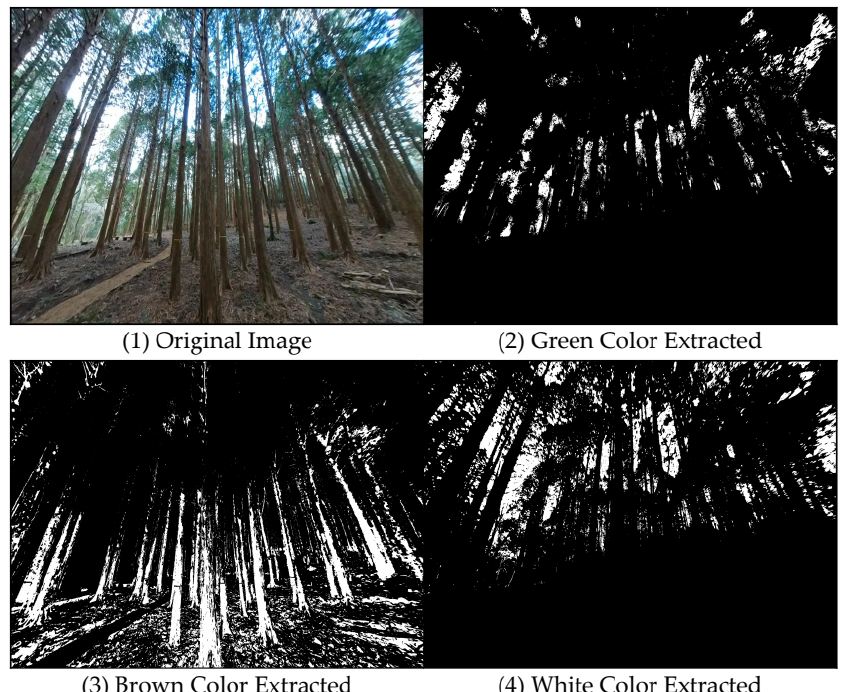
Figure 3. Example of color-extraction process.